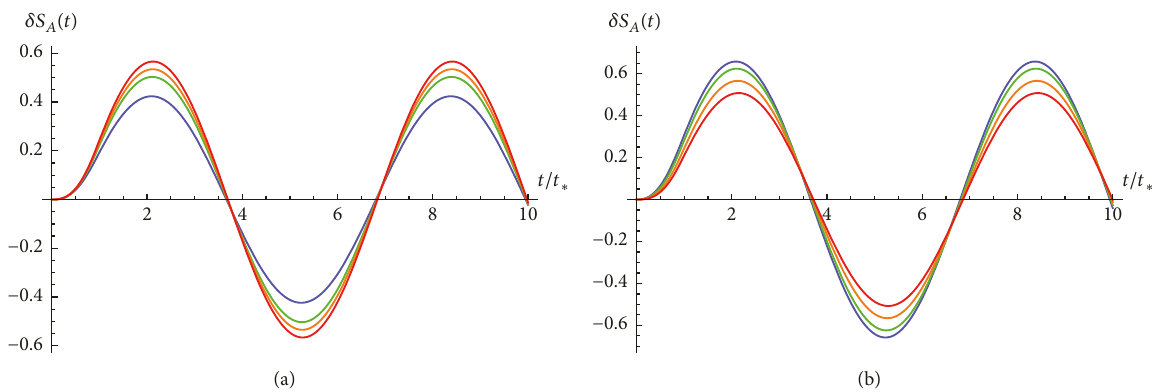
Figure 13: Entanglement entropy after a Floquet quench as a function of (a) 𝜃 and (b) 𝑧 . The colors blue, green, orange, and red denote 𝜃 = {1.3,0.8, 0.5,0.1} in part (a) and 𝑧 = {2.1,1.8,1.5,1.3} in part (b), respectively. We have set 𝑑 = 3 , Ω = 1 .